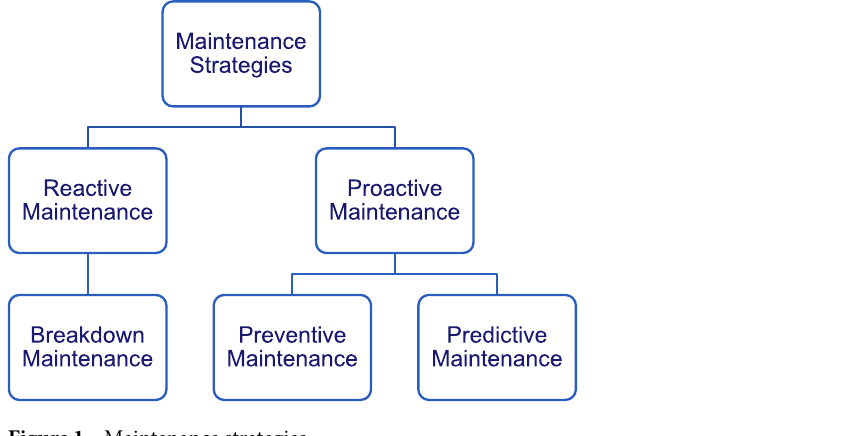
Figure 1. Maintenance